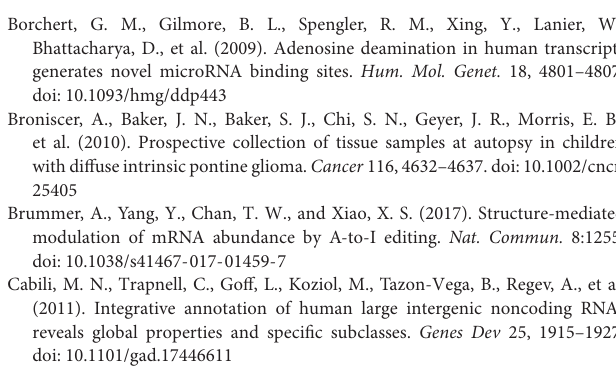
FIGURE S1 | Histogram of shared RNA editing sites across multiple cancers filtered by four different average RNA editing level: A > 0%, B > 10%, C > 25%, D > 50%. Majority of the RNA editing sites occurs only in 1 or 2 cancers. FIGURE S2 | Scatter plot between number of RNA editing found and sample size in the 14 TCGA cancer types. No correlation was observed. FIGURE S3 | Pie charts to display the distribution of RNA editing events by genomic location categories by each cancer type. FIGURE S4 | Manhattan plots that depicting the genome-wide results of RNA editing level difference between tumor and normal samples in TCGA. FIGURE S5 | Genome-wide RNA editing frequency for all chromosomes. TABLE S1 | All RNA editing positions across the 14 cancer types examined. TABLE S2 | The number of RNA editing events detected in both GTEx and TCGA. TABLE S3 | Differential RNA editing results. TABLE S4 | Functional analysis results from DAVID. TABLE S5 | Common functional categories shared by cancers from genes with RNA editing events. TABLE S6 | Top 10 hyper editing genes by